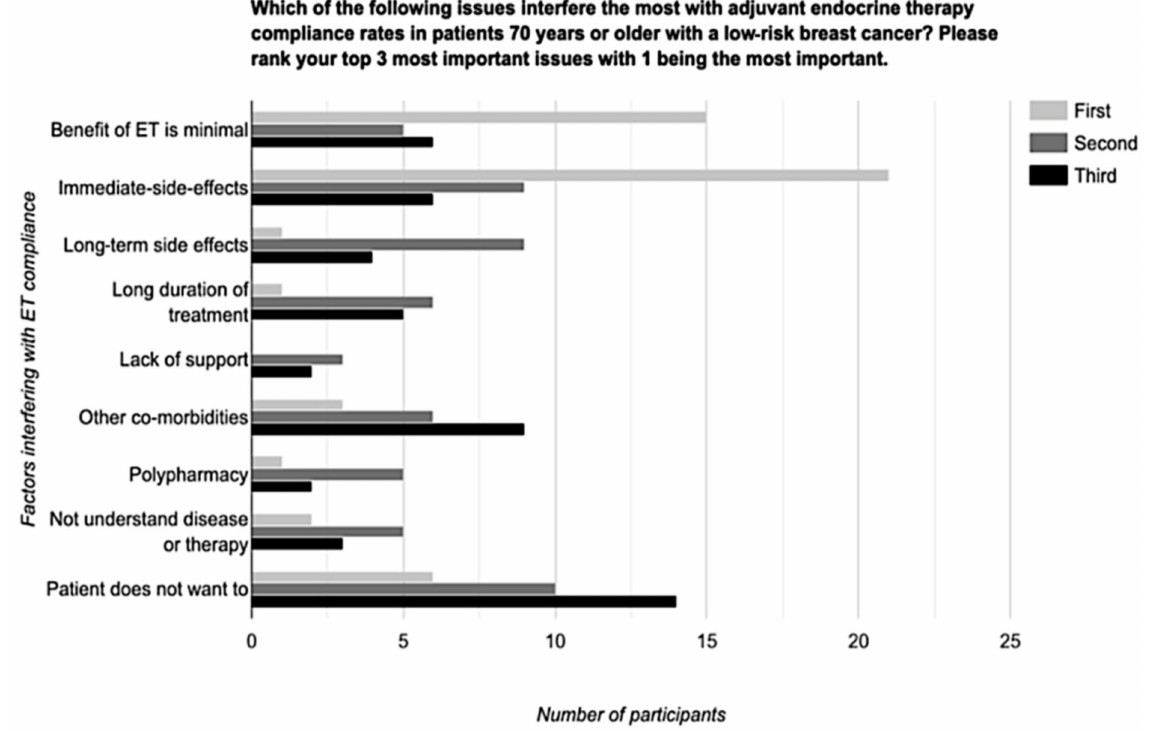
Figure 1. Factors that oncologists identified as interfering with ET compliance in patients aged ≥ 70 with a low-risk breast